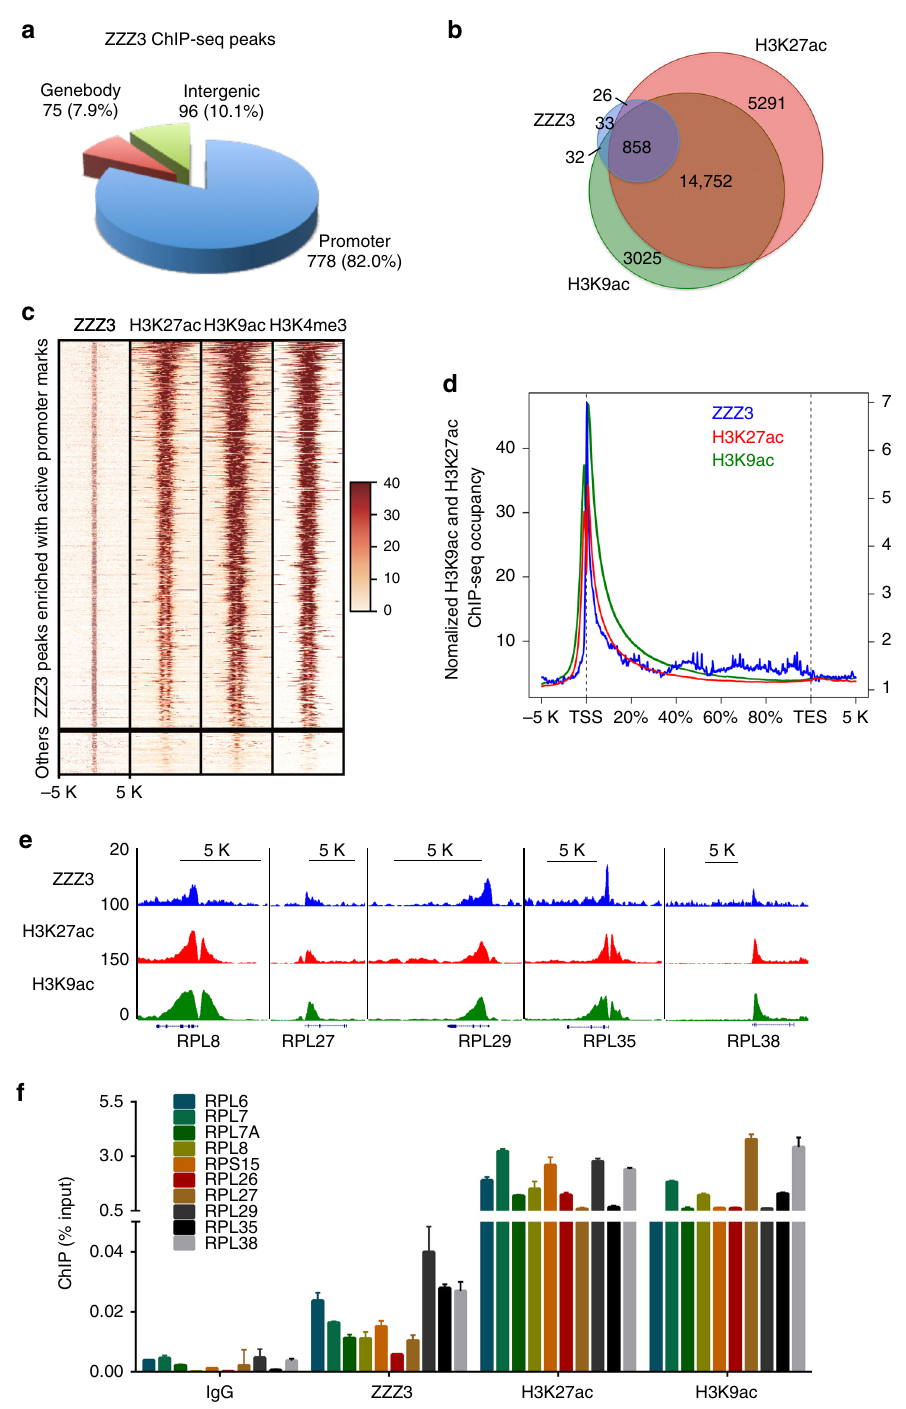
Fig. 4 The ATAC complex co-localizes with promoter H3K27ac genome-wide. a Genomic distribution of ZZZ3 ChIP-seq peaks in H1299 cells. The peaks are enriched in the promoter regions (transcription start site ± 3kb). p < 2.2 × 10 − 16 (binomial test). b Venn diagram showing the overlap of ZZZ3 (blue), H3K27ac (red) and H3K9ac (green) occupied peaks. p < 1.79 × 10 − 63 (Super exact test). c Heatmaps of normalized density of ZZZ3, H3K27ac, H3K9ac and H3K4me3 ChIP-seq tags centered on ZZZ3-binding peaks in a ± 5 kb window. The color key represents the signal density, where darker red represents higher ChIP-Seq signal. d Average genome-wide occupancies of ZZZ3 (blue), H3K27ac (red) and H3K9ac (green) along the transcription unit. The gene body length is normalized by percentage from the TSS to transcription termination site (TES). 5 kb regions upstream of TSS and 5 kb regions downstream of TES are also included. e Genome-browser view of the ZZZ3-ChIP-seq (blue), H3K27ac-ChIP-seq (red), and H3K9acChIP-seq (green) peaks on the indicated ribosomal protein genes. f qPCR analysis of ZZZ3, H3K27ac and H3K9ac ChIP in the promoters of representative ribosomal protein genes. IgG was used as a negative control. Error bars indicate S.E.M. of three biological